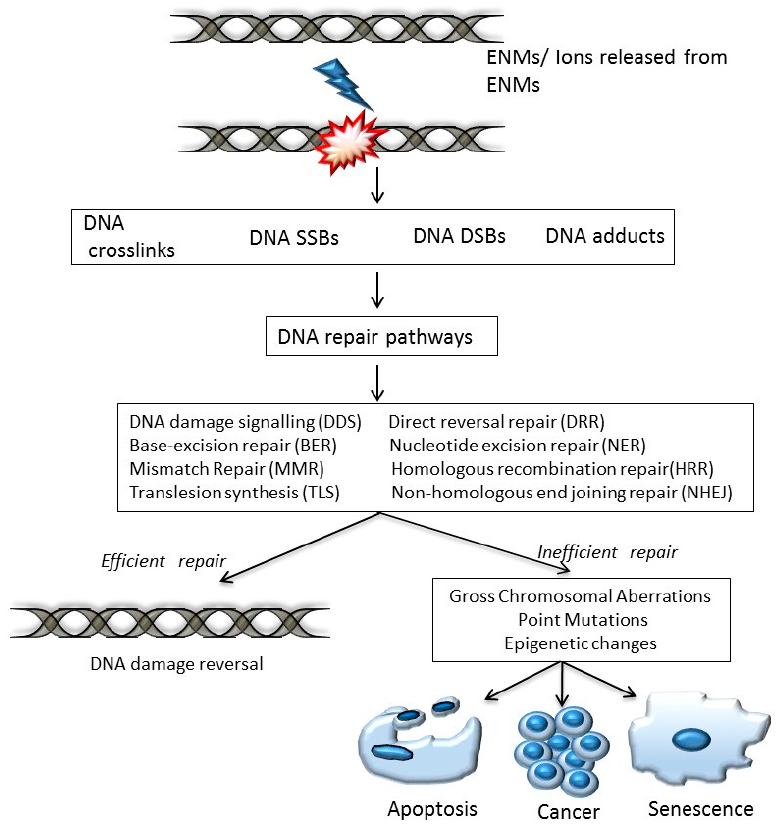
Figure 1. Schematic to illustrate various types of DNA damage caused by engineered nanomaterials (ENMs) that may result in efficient or inefficient repair activity, leading to either DNA damage reversal or progression to carcinogenesis, apoptosis and/or senescence, respectively. SSB: single strand breaks, DSB: double strand breaks.